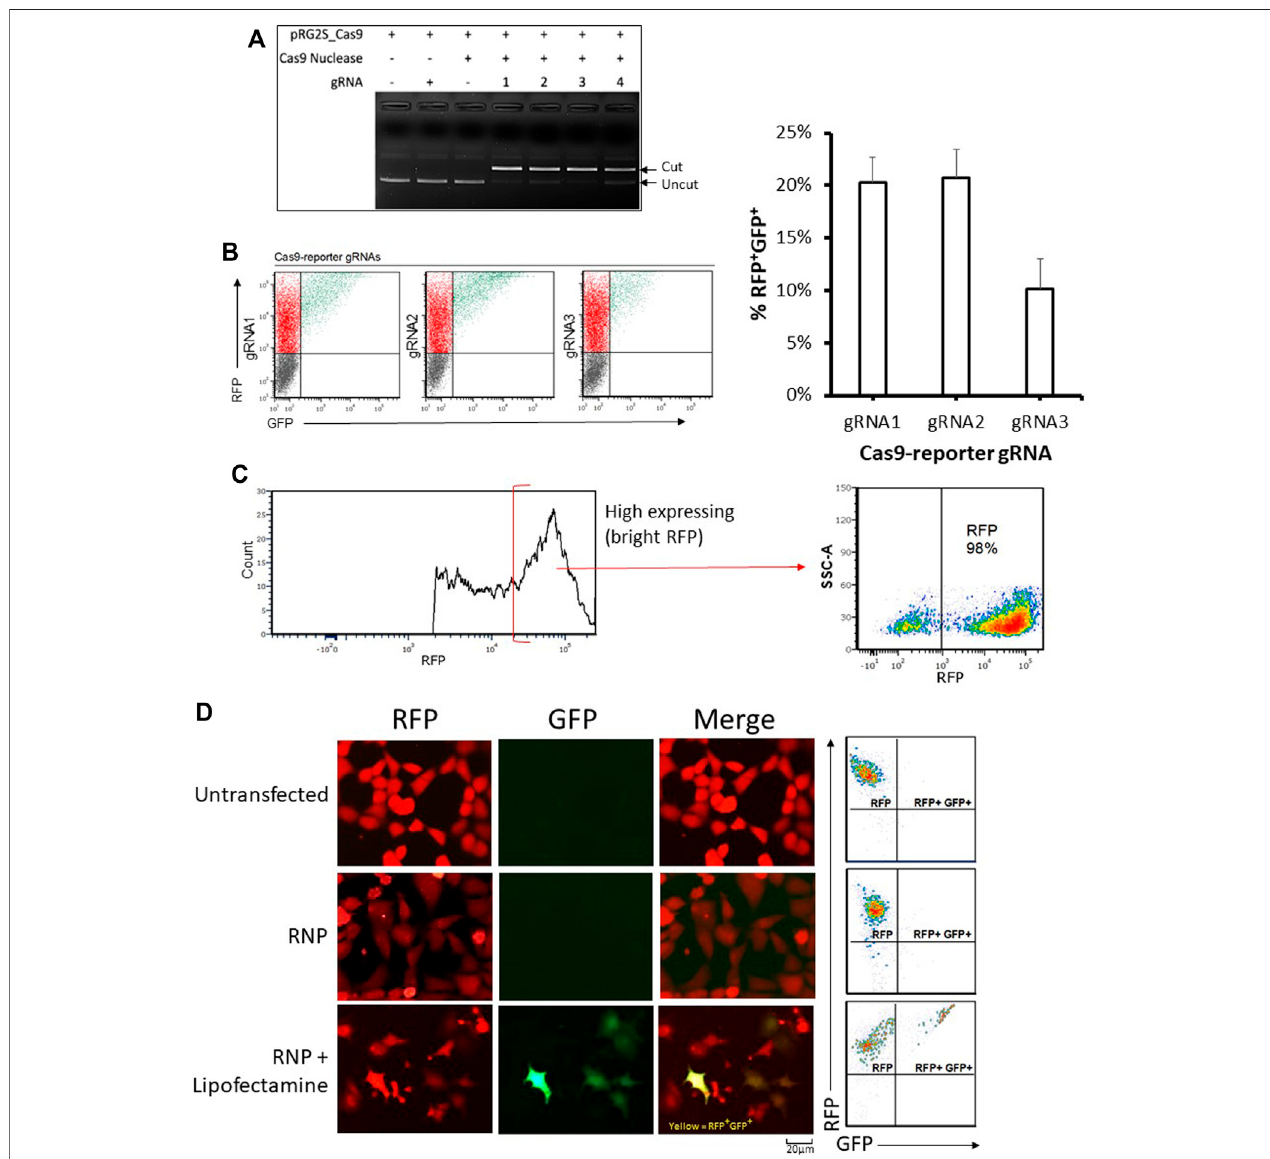
FIGURE 2 | Analysis of genome editing using the stable reporter system. (A) In-vitro cleavage assay. The four reporter-gRNAs targeting the reporter construct ’ s Cas9 target sequence are incubated separately with Cas9 nuclease and the reporter plasmid for 1 h at 37 ° C and then the reactions are subjected to agarose gel electrophoresis to con fi rm the gRNAs ’ ability to induce double-stranded breaks within the target sequence. (B) Cellular reporter assay fl ow-cytometry dot plots. Flow- cytometric analysis of HEK293 cells co-transfected with the reporter plasmid, a Cas9-expression plasmid and DNA fragments encoding each of the four reporter- gRNAsunderaU6promoter,usingFuGENE.Quanti fi cationofnucleaseactivityisshownontheright.Resultsareexpressedasmean±standarderrorofthemean: n =5 for reporter-gRNA1 and gRNA2; and n = 4 for gRNA3. (C) A highly stable population of fl uorescent reporter cells (~98% RFP) expressing the reporter construct were sortedusingacellsorter. (D) Examplesof fl owcytometry-basedanalysisand fl uorescencemicroscopy-baseddetectionofstablereporterHEK293cellsculturedfor72 h after transfection with Cas9/reporter-gRNA2 ribonucleoprotein using Lipofectamine CRISPRMAX. Scale bar = 20 µm.